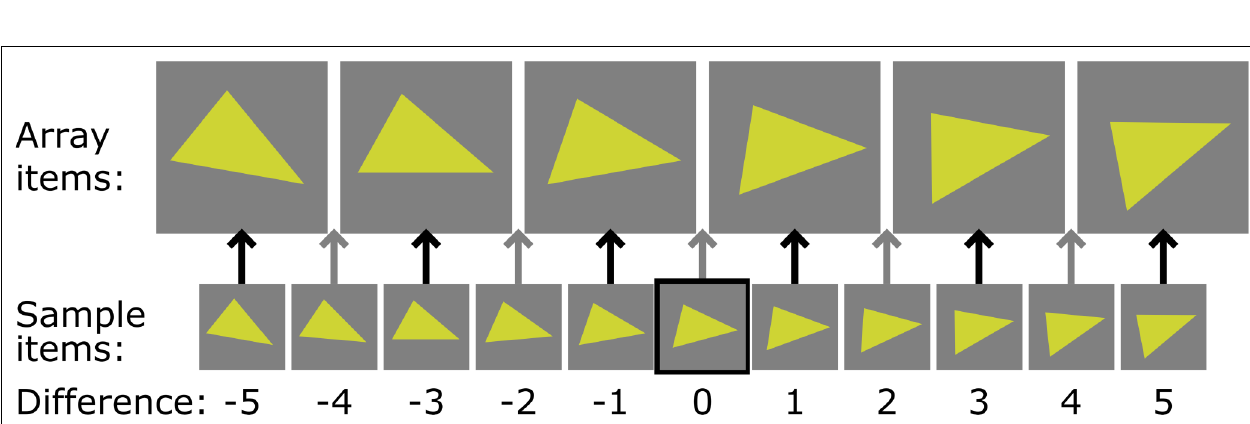
FIGURE 4 | Explanation of the difference measure. Six values along the continuum (here orientation) always comprised the search array. Eleven different values were used for sample items: six values that matched one array item; and fi ve values falling between the values of array items. Our “difference” predictor was based on the number of potential sample items between the value of a given trial’s sample item and the value of a fi xated array item.